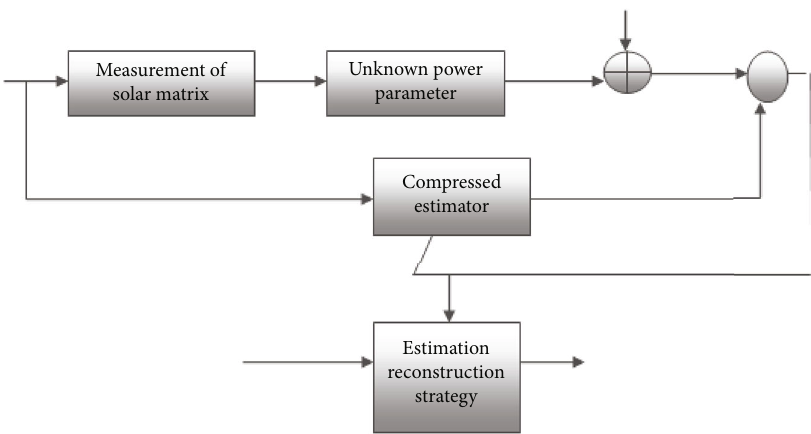
Figure 3: Proposed model